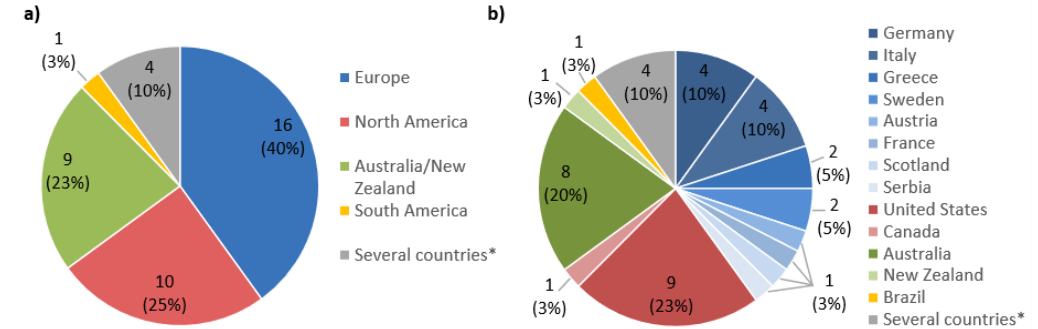
Figure 2. Geographical location of studies. ( a ) Distribution of studies according to the continents of their origin. ( b ) Distribution of studies according to their country of origin. ( n = 40 studies). * Four studies used data sets from multiple countries with high melanoma incidences for the development of their risk prediction model.